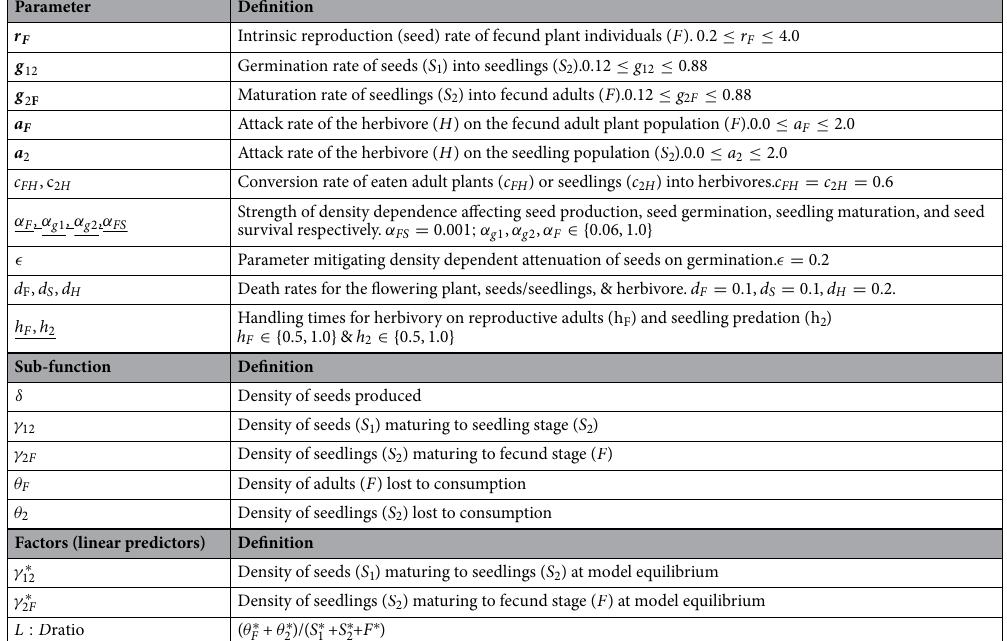
rate by fecund adults ( r F ). The trophic parameters are the attack rates of herbivores ( H ) on seedlings ( a 2 ) and fecund adults ( a F ). These five rates represent both demographic and trophic flow, a functional basis for studying how plant ontogeny interacts with trophic dynamics (Fig. 1A). We informed the ranges of demographic parameter values simulated in our parameter sweeps using empirical data of three-stage plant population dynamics 22 . Reproduction from the third stage ( F ) into the first stage ( S 1 ) displayed a large range of values but was highly left skewed, with ~ 87% of values ≤ 10. Our exploratory analysis was done with r F ≤ 10 and detailed analysis held at r F ≤ 4 (Appendix S1.2; Fig. S1a). Stage transitions, on the other hand, are much more evenly distributed between 0 and 1 (Fig. S1b,c), so analysis considered 0.12 < g 12 , g 2 F ≤ 0.88. Despite the skewness in the data, analysis reveals no correlation between any demographic rates, indicating no appreciable covariation between parameters (Appendix S1.3; Fig. S2). In demographic terms, no covariation between these rates means there was no clear evidence of tradeoffs such that, for example, a higher seed production rate necessitated lower germination rates, or direct correlative relationships between the stage transition rates. The range of herbivore attack rates was chosen heuristically (see Table 1). The lack of any appar- ent restrictions or relationships with parameter values spurred a broad factorial parameter sweep across all five parameters via cluster computing. We duplicated the five parameter factorial sweep across a range of handling times and degrees of density dependence to test for ubiquity in qualitative results, producing nearly 5.5 million simulations.